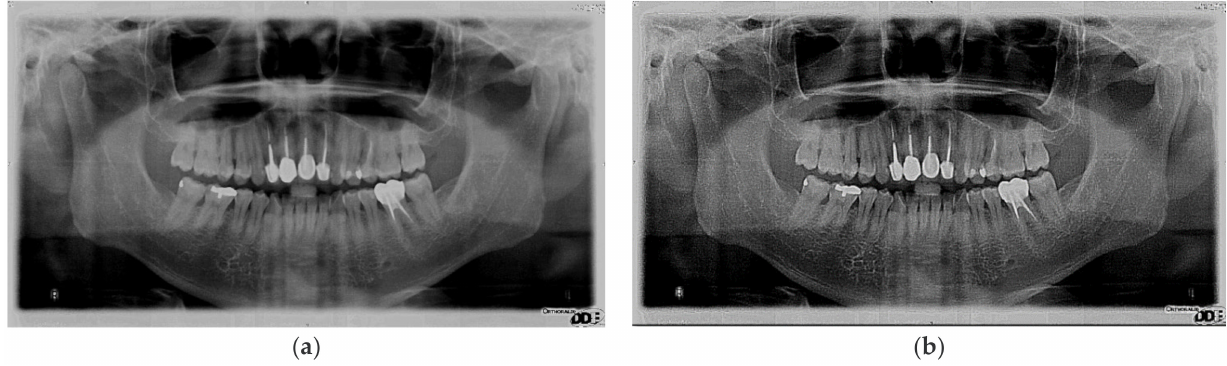
Figure 3. Schematic diagram of the images used in this study. ( a ) Original image. ( b ) Schematic diagram of the matrix